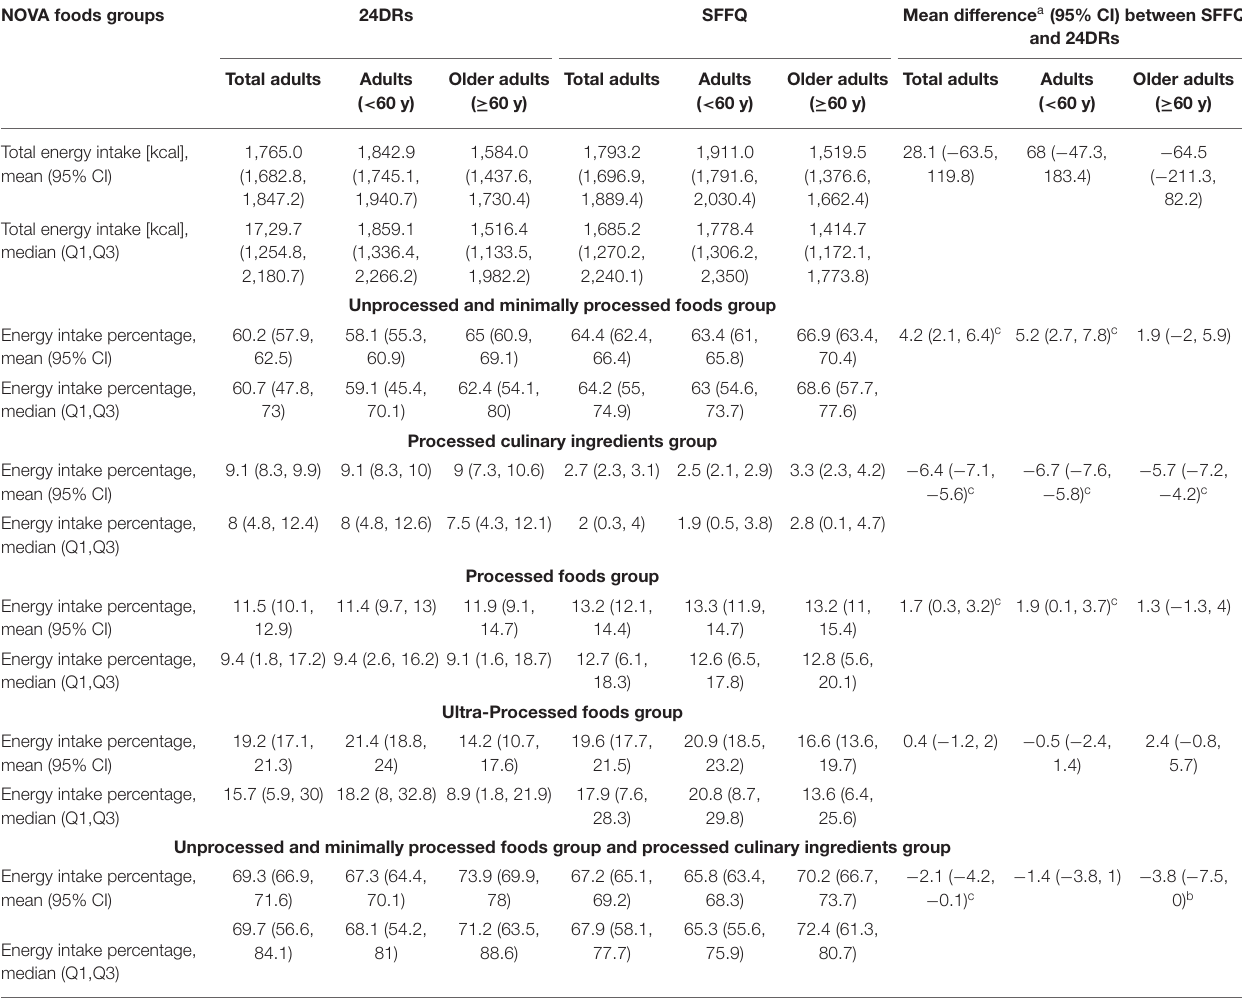
TABLE 2 | Percentage energy intakes and difference mean between SFFQ and 24DRs in adults and older adults in NOVA foods groups. NOVA foods